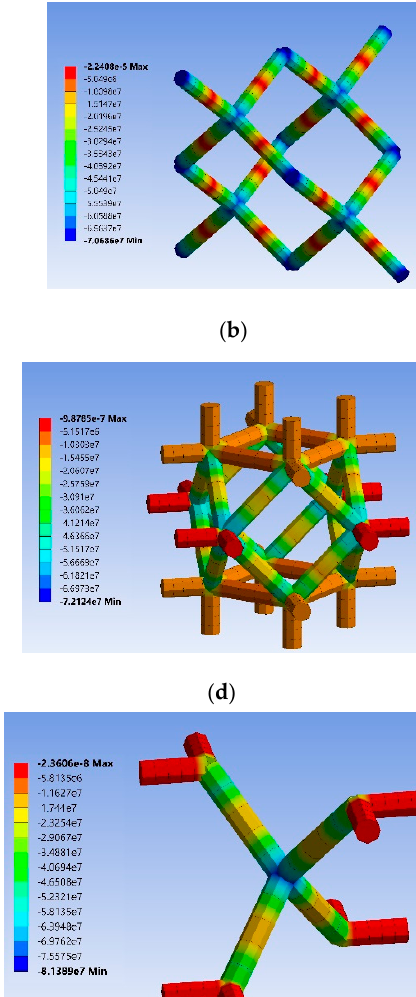
Figure A3. Axial stress of unit cells: ( a ) BCC; ( b ) diamond; ( c ) hexagonal packing; ( d ) rhombicuboctahedron; ( e ) truncated cube; and ( f ) truncated octahedron in ANSYS.